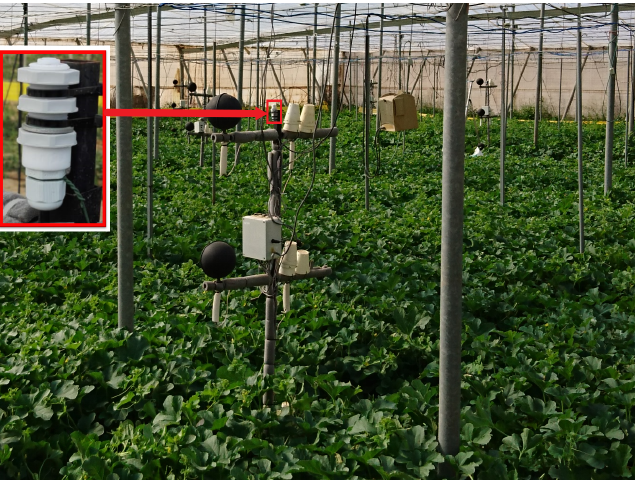
Figure 2. Interior of the greenhouse studied and detail of one of the sensors installed for the measurement of UV